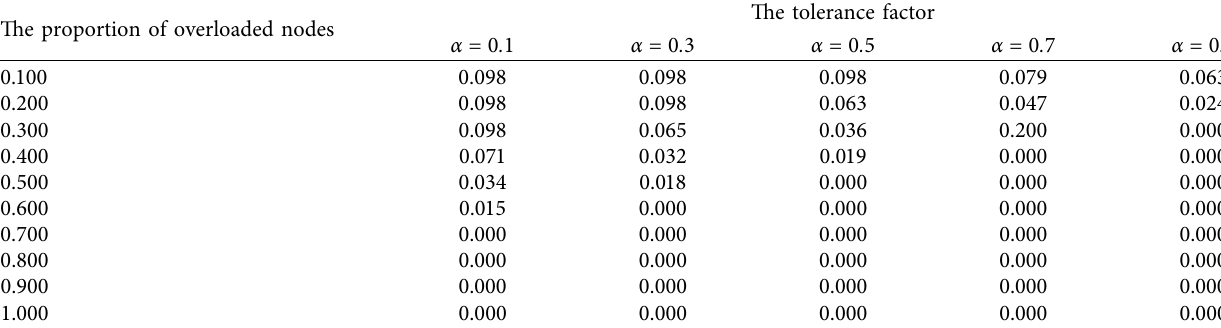
Table 11: Average network efficiency